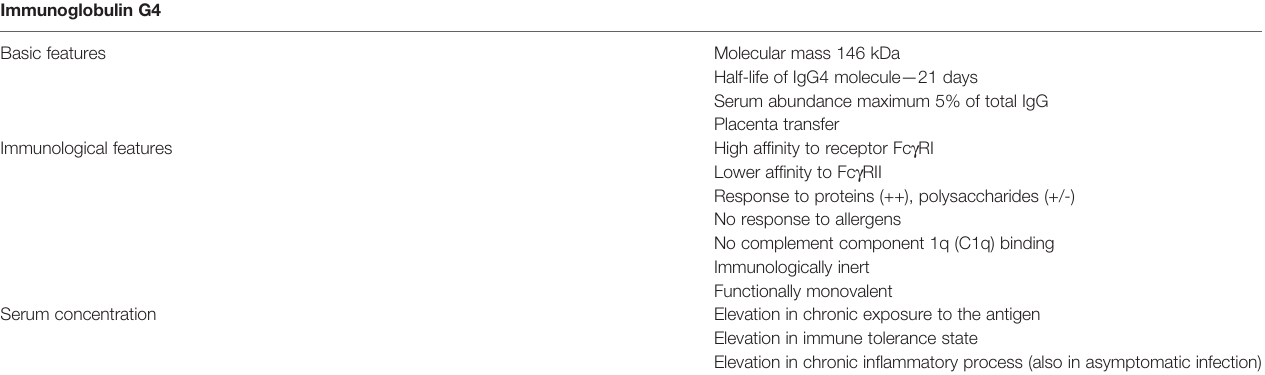
TABLE 2 | Immunoglobulin G4 main characteristic (2,